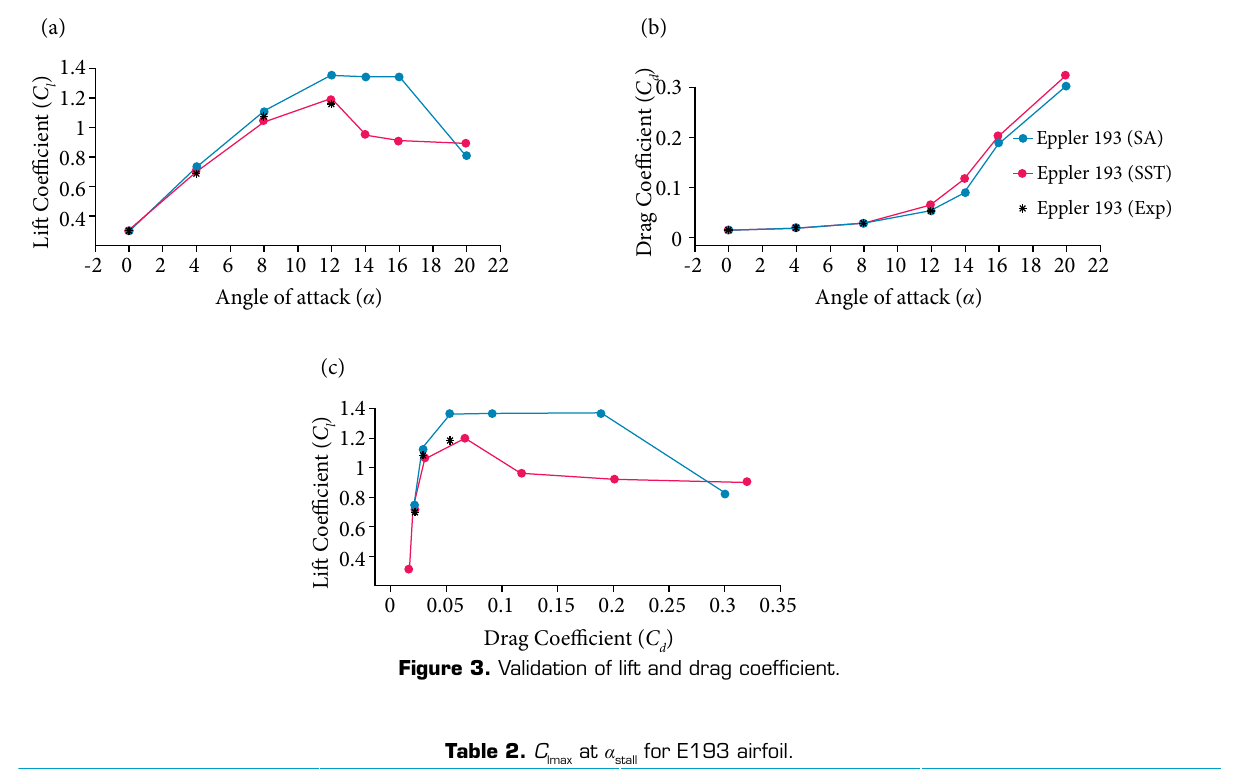
at α for E193 lmax stall